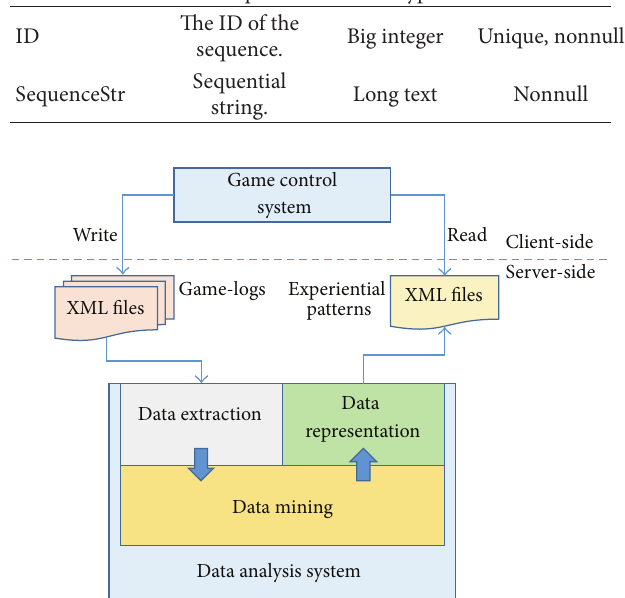
Figure 1: Workflow of the data mining process.